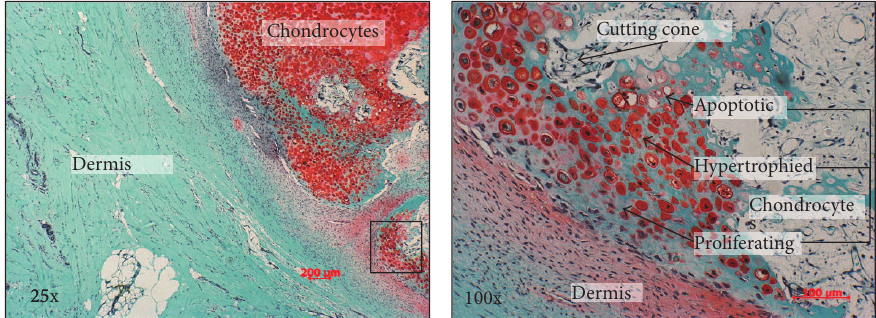
Figure 3: Safranin-O (25x) demonstrates cartilage cap with endochondral bone formation underlying the dermis. Zone of proliferation, hypertrophy, and apoptosis with new bone formation are identified at 100x. These findings are consistent with osteochondroma.